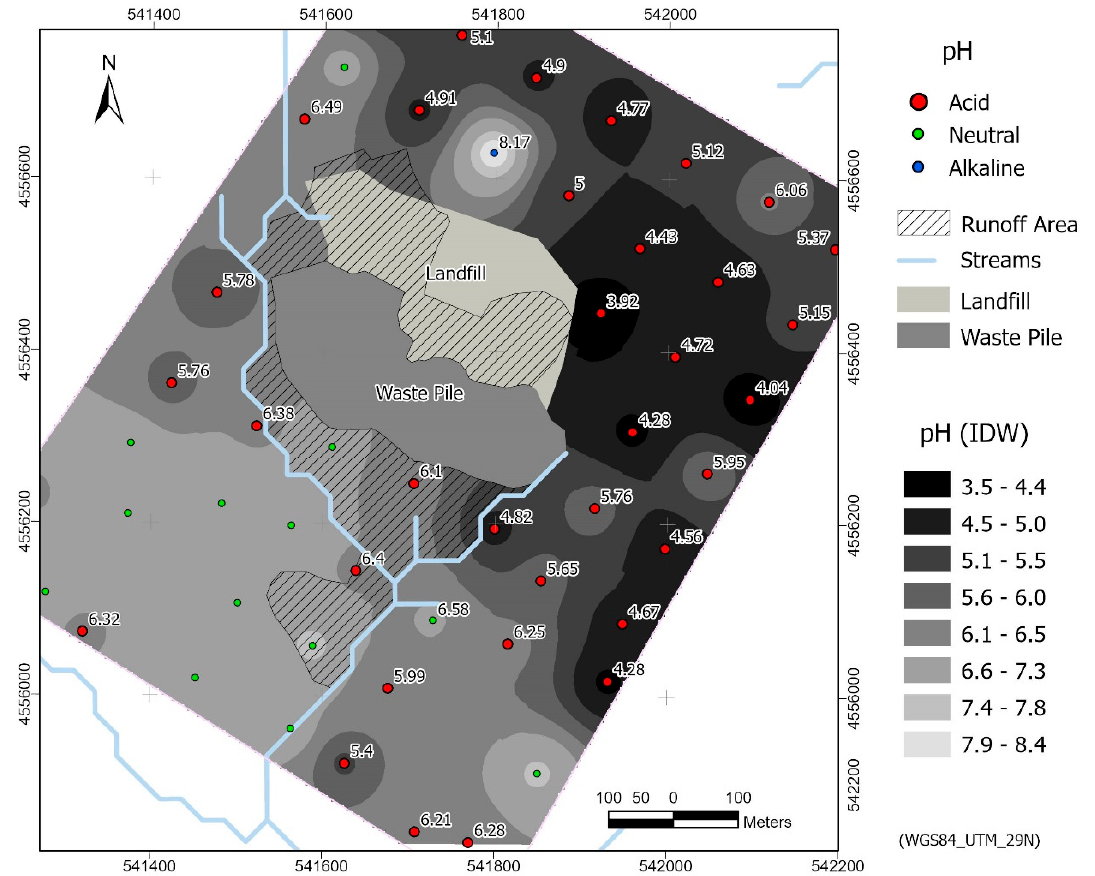
Figure 3. pH spatial distribution interpolated by inverse distance weighting (IDW), overlayed by individual pH measurements for each soils sample from the study area.